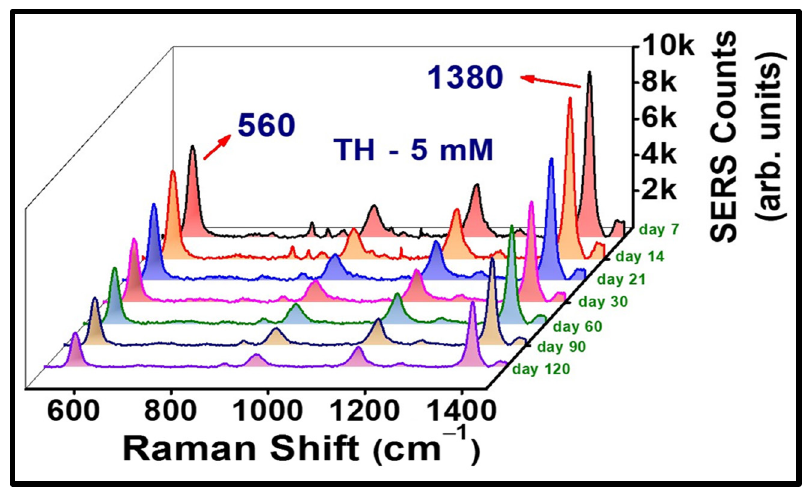
Figure 13. Stability data of the 20 nm Au-coated AgNS2 in sensing TH (5 μ M) molecule, illustrating a superior performance compared to bare AgNS2.